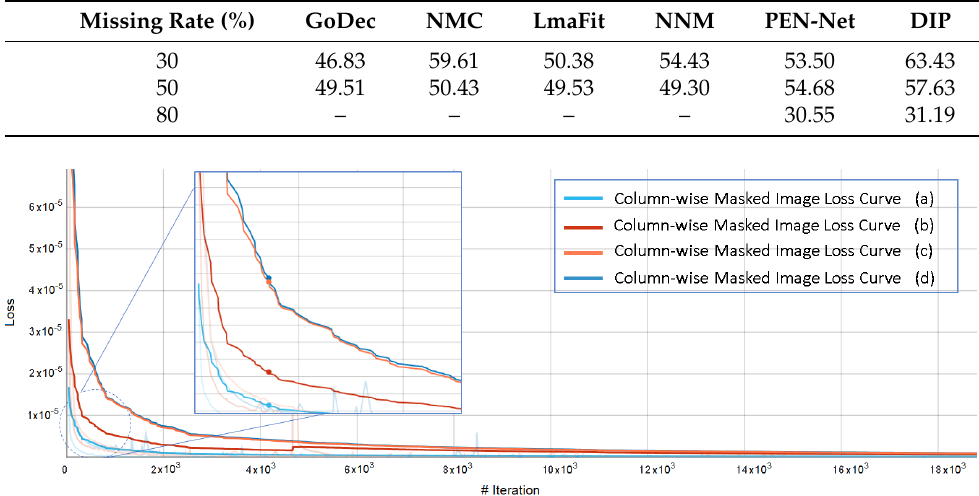
Table 3. PNSR comparison of data recovery methods for column-wise missing data.